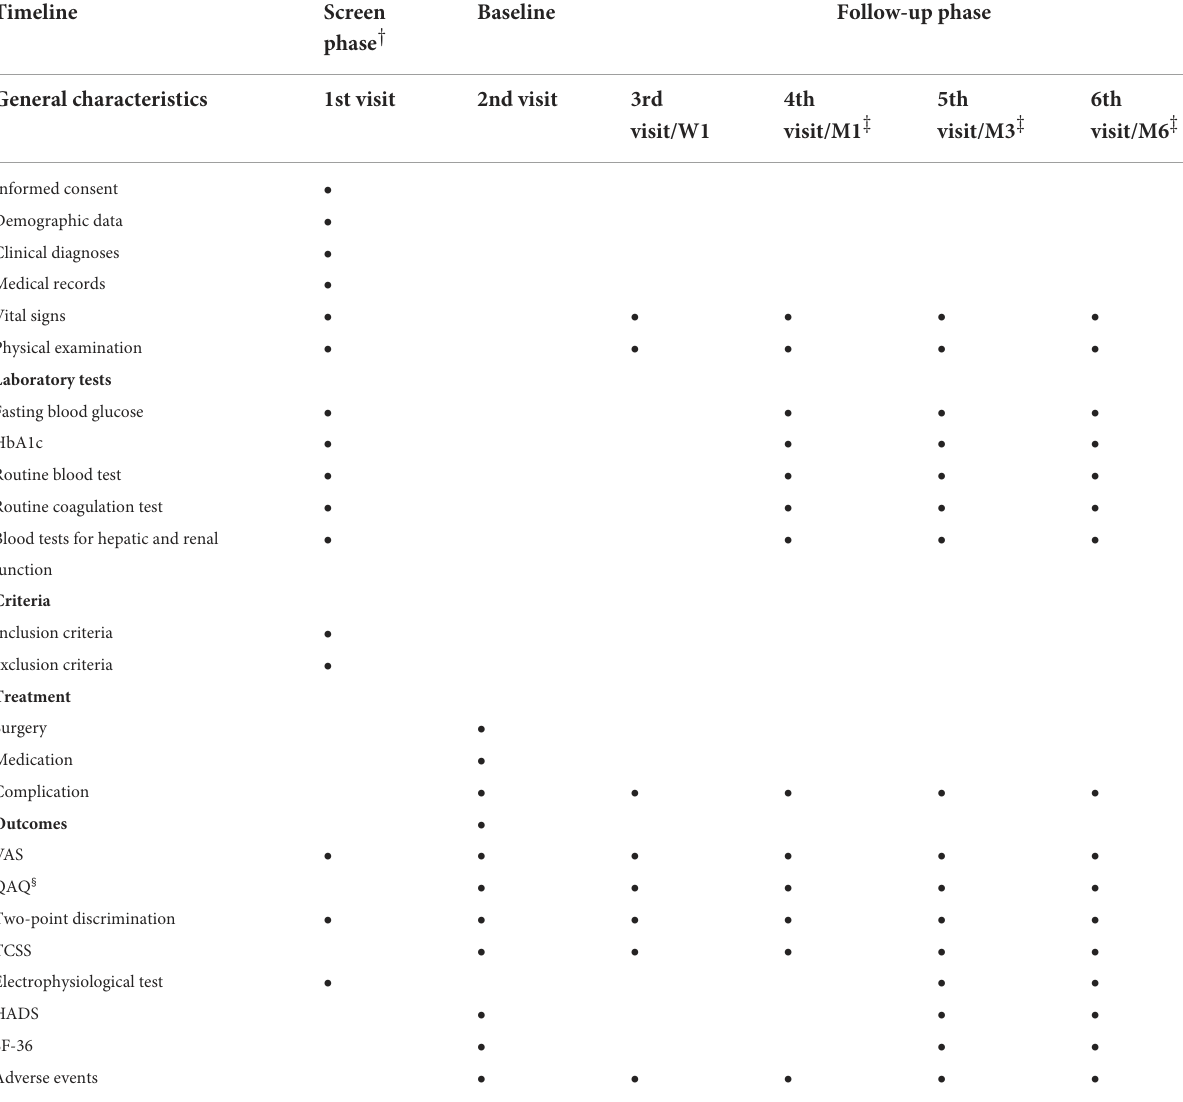
TABLE 2 Study protocol timeline per subject. Timeline